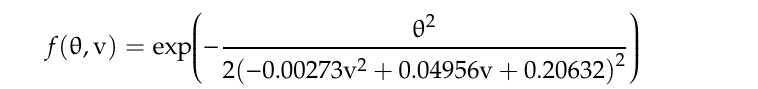
Figure 17. Fitting of data using Gaussian function: ( a ) case of 6 m/s wind speed, R 2 = 0.8417; ( b ) case of 10 m/s wind speed, R 2 = 0.8892; ( c ) case of 15 m/s wind speed, R 2 = 0.9465.